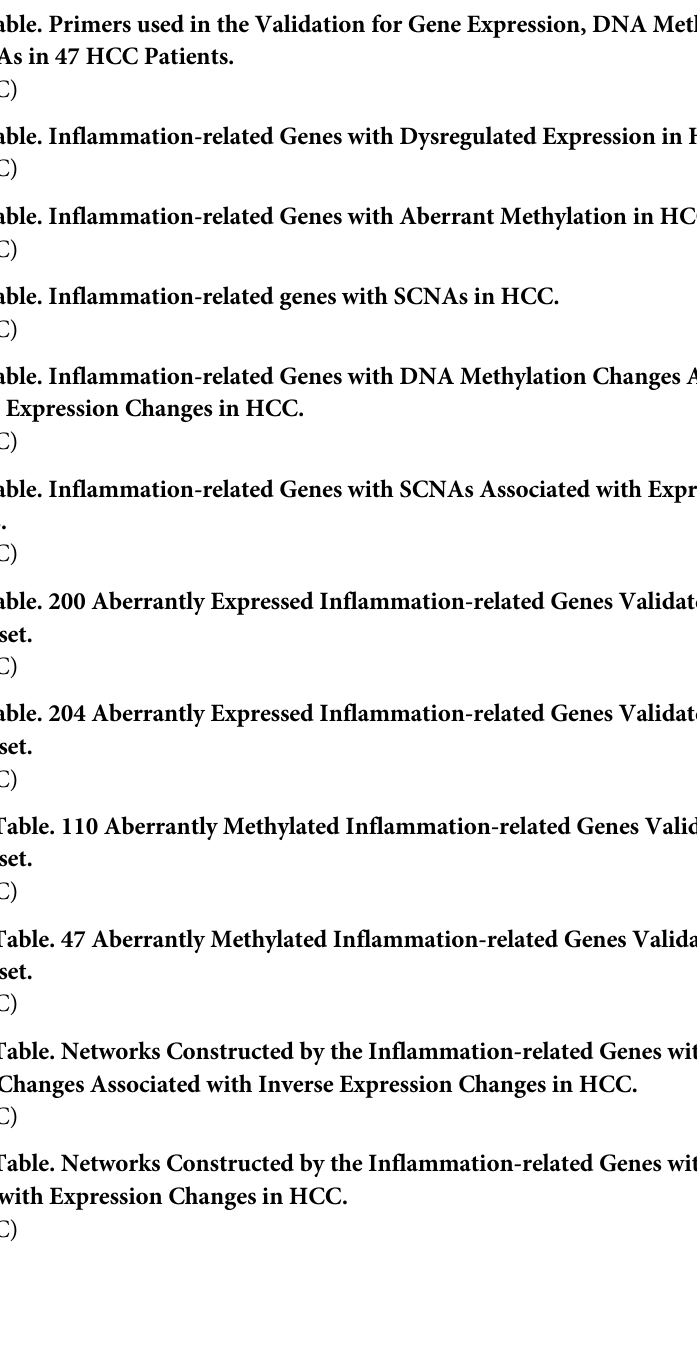
S12 Table. Networks Constructed by the Inflammation-related Genes with DNA Methyla- tion Changes Associated with Inverse Expression Changes in HCC. S13 Table. Networks Constructed by the Inflammation-related Genes with SCNAs Associ- ated with Expression Changes in